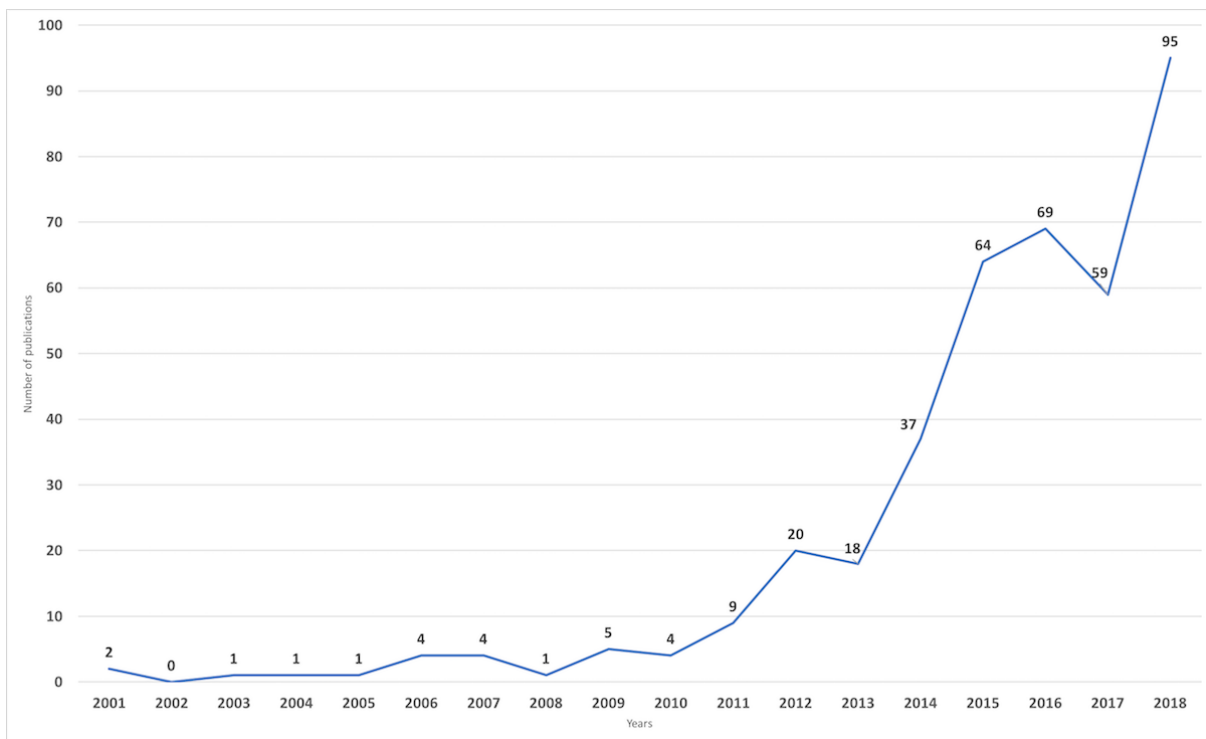
Figure 2. Publication trend from 2000 to 2018.